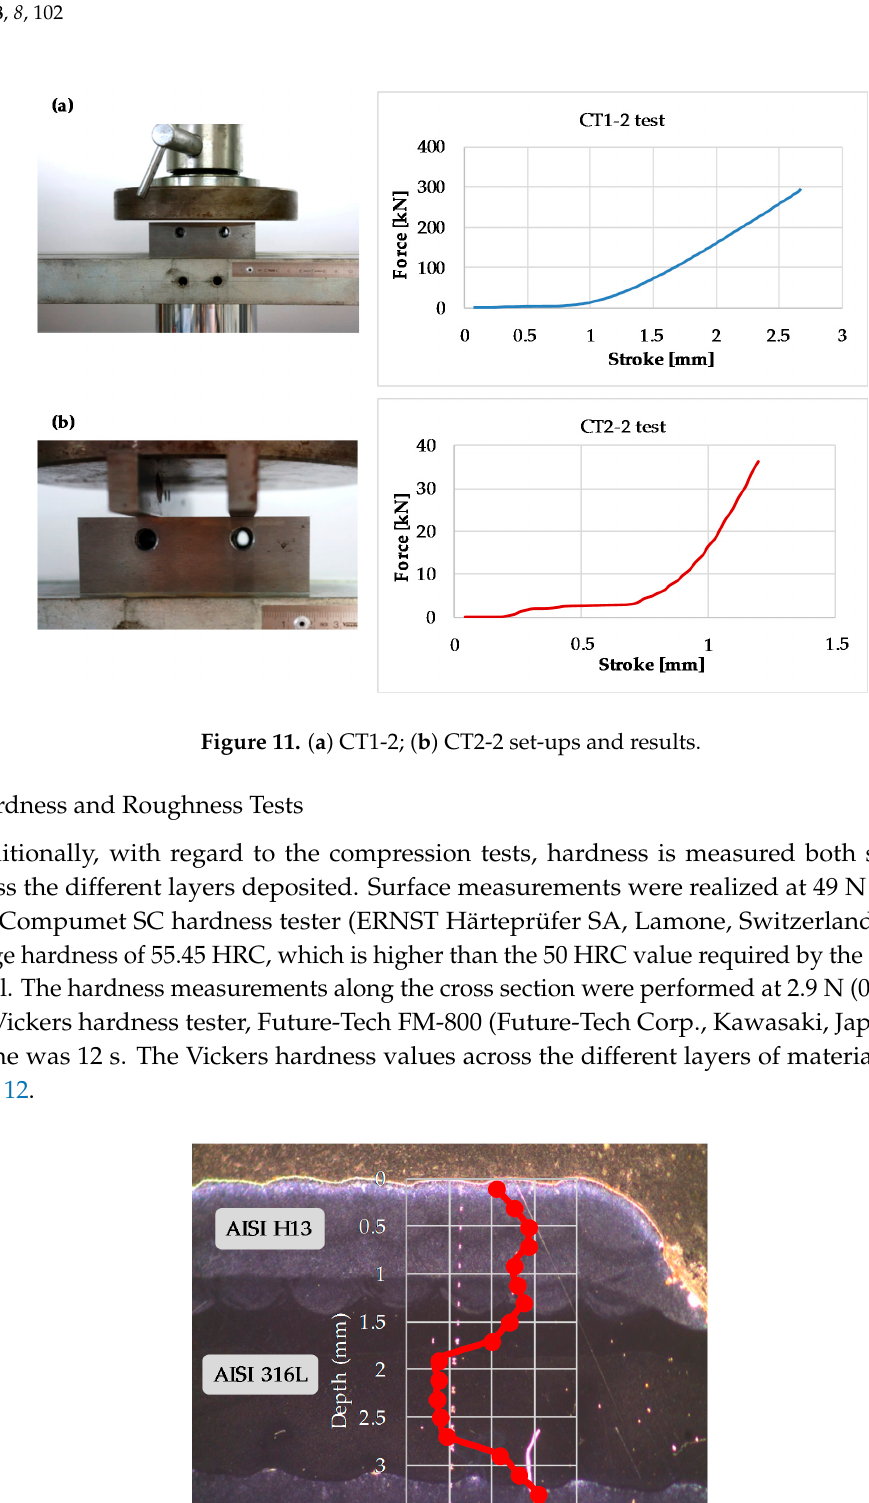
Figure 12. Vickers hardness values of the deposited materials and substrate.